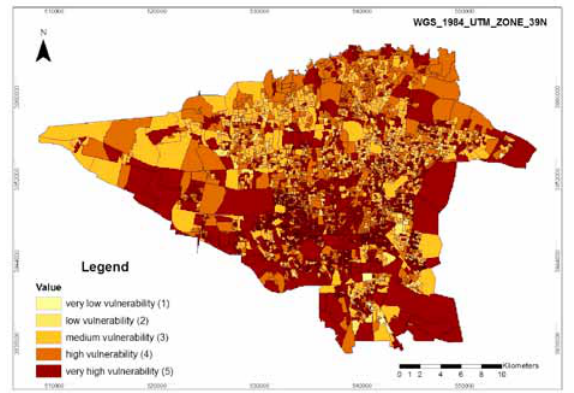
Fig. 4. Tehran’s seismic vulnerability map using association rules and exception rules